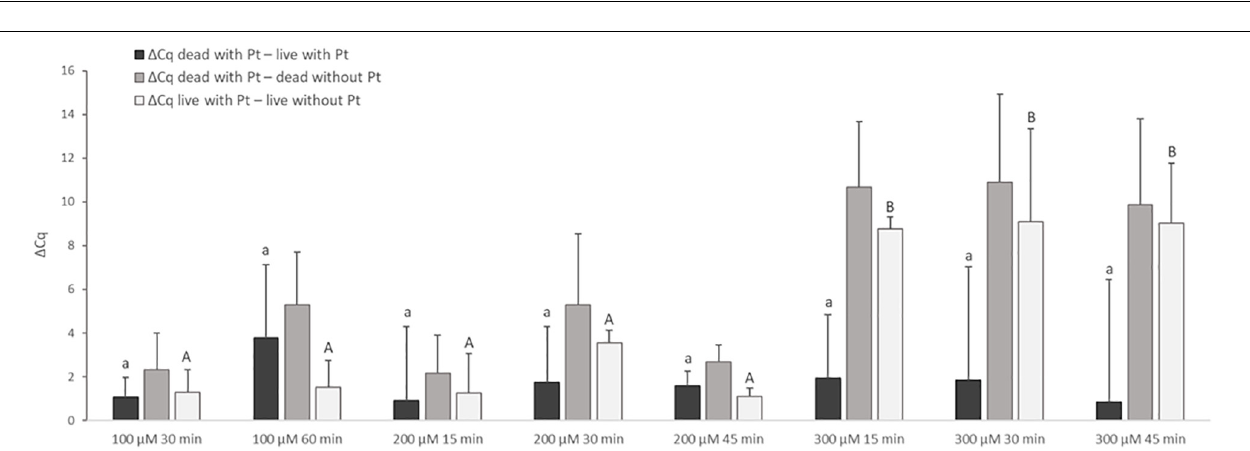
FIGURE 3 | Effect of treatment of M. smegmatis cells with cis -dichlorodiammine platinum(II) at different concentrations and for different times. The aim was to find the treatment condition providing the highest possible value for (cid:49) Cq dead with Pt − live with Pt and (cid:49) Cq dead with Pt − dead without Pt and the lowest possible value for (cid:49) Cq live with Pt − live without Pt . The (cid:49) Cq values express the individual mean differences of Cq values calculated from four replicates (biological and technical). The significance of differences between (cid:49) Cq was calculated by one-way ANOVA and Tukey’s HSD test. The same letters indicate statistically insignificant differences ( P > 0.05) between (cid:49) Cq values, while different letters indicate significant differences ( P < 0.05). The values of (cid:49) Cq dead with Pt − live with Pt were marked with lowercase letters, and the values of (cid:49) Cq live with Pt − live without Pt were marked with capital letters, as it was evaluated separately. Error bars represent standard deviations calculated from four